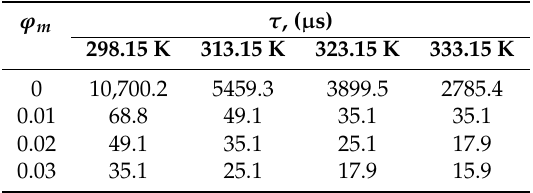
Figure 7. Dielectric loss tangent, tan δ , of silicon oxide lignin ethylene glycol nanofluids as function of frequency for temperature ( a ) 298.15 K, ( b ) 333.15 K. Table 1. Values of relaxation time, τ , for various nanofluids concentration at temperature between 298.15 K and 333.15